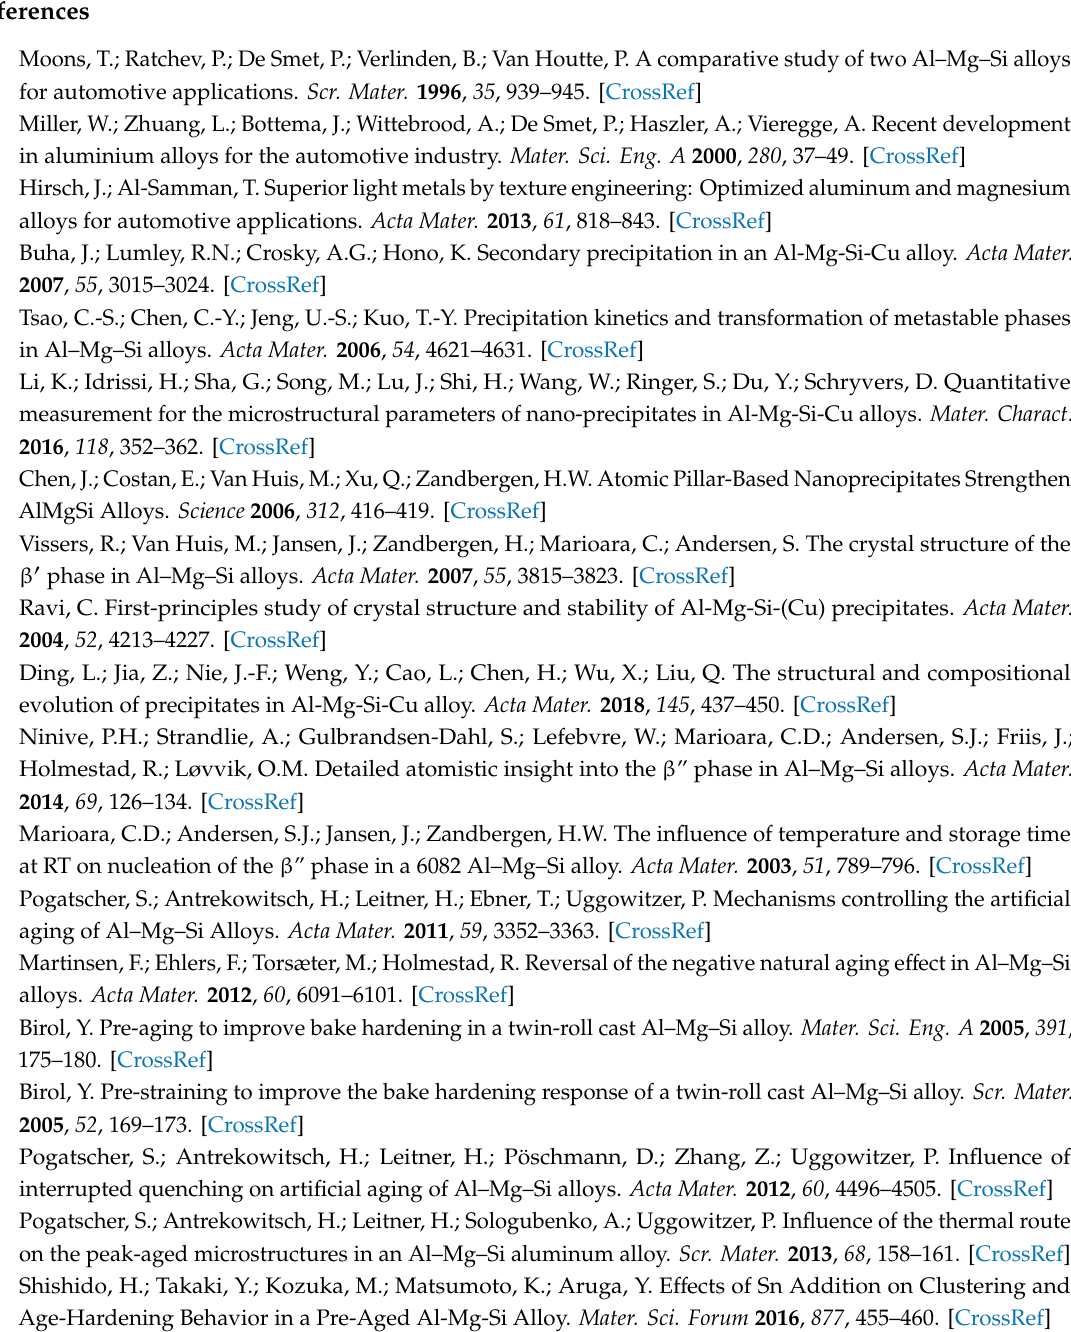
e ff ect of β ” precipitates in the alloy with 0.58 Mg / Si ratio, and decreased the yield and tensile strength of the peak aged alloy by 12.5 and 5.8 MPa,